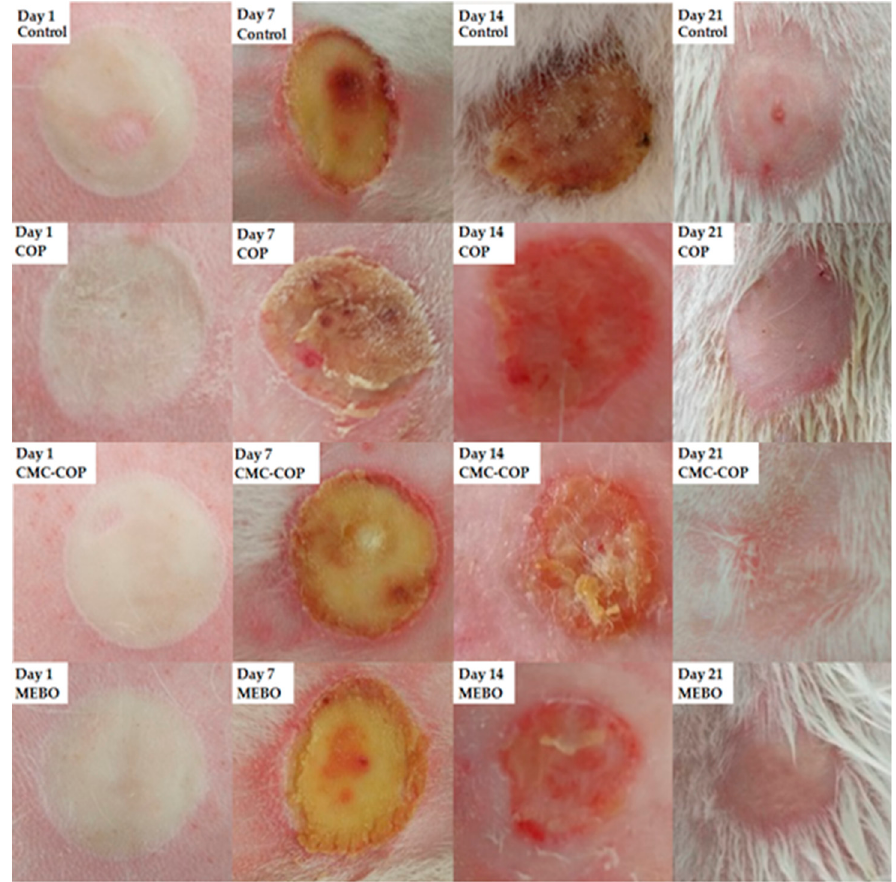
Figure 7. Macroscopic analysis of cutaneous wounds on days 1, 7, 14, and 21 following treatment with COP, CMC – COP, or MEBO (commercial burn